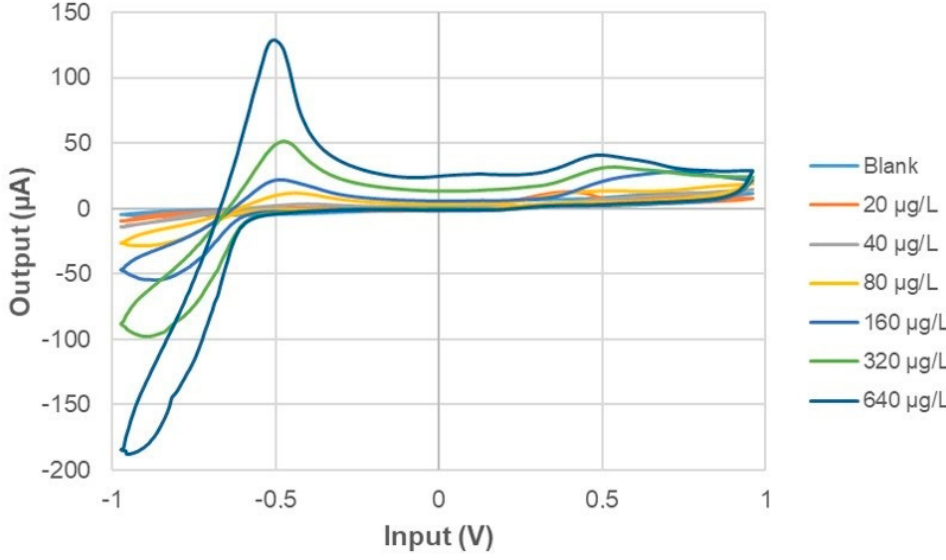
Figure 4. Voltammograms obtained as output current of the BIONOTE-L when calibrated with different concentration levels of iodide in the range 0–640 μ g/L.